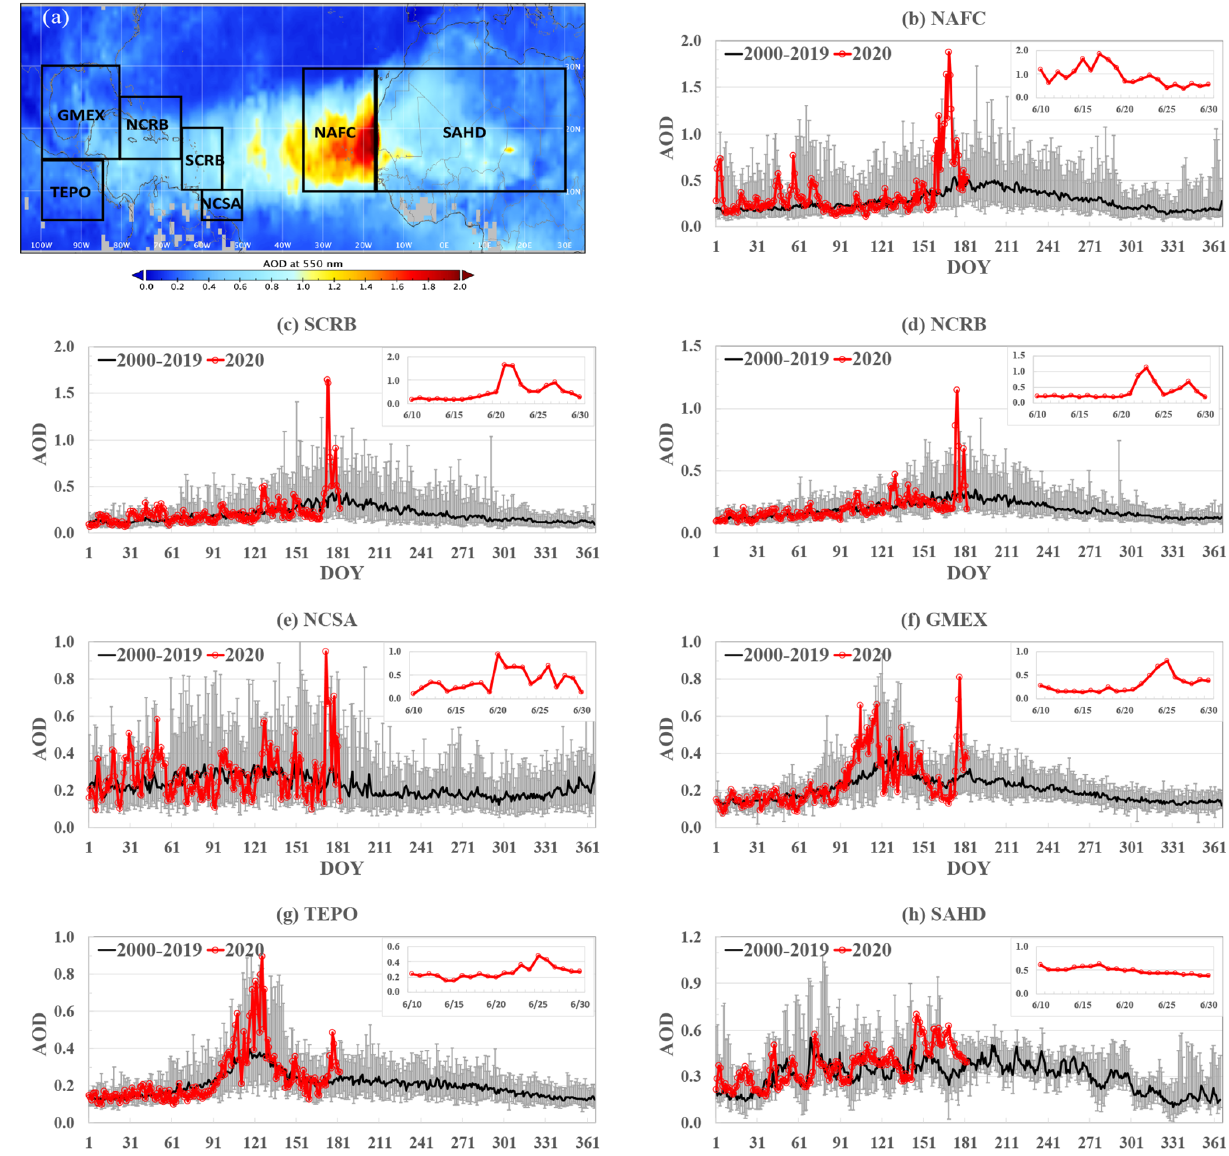
Figure 9. MODIS Terra daily AOD for 2020 (red dot and thick line) in comparison to 2000–2019 climatology (the median and range of daily AOD are represented by the thick black line and gray vertical bar, respectively) in seven regions defined in (a) , including (b) NAFC, (c) SCRB, (d) NCRB, (e) NCSA, (f) GMEX, (g) TEPO, and (h) SAHD. The insets in (b–h) zoom in on the day-to-day variations in